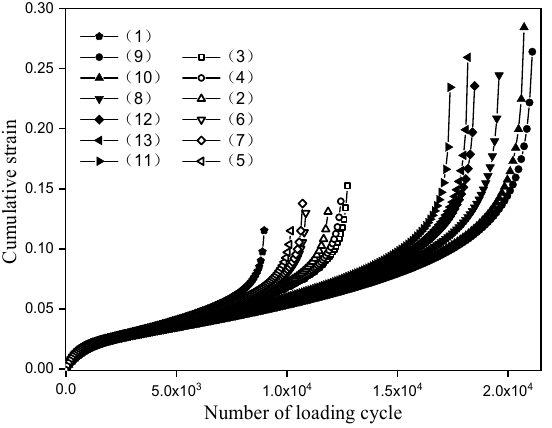
Figure 7. Split fatigue test results.